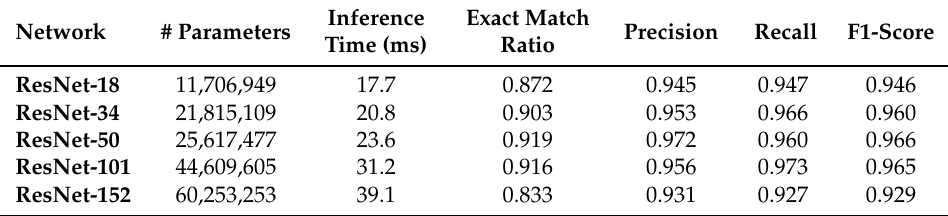
Table 5. Test set performance of different ResNet model